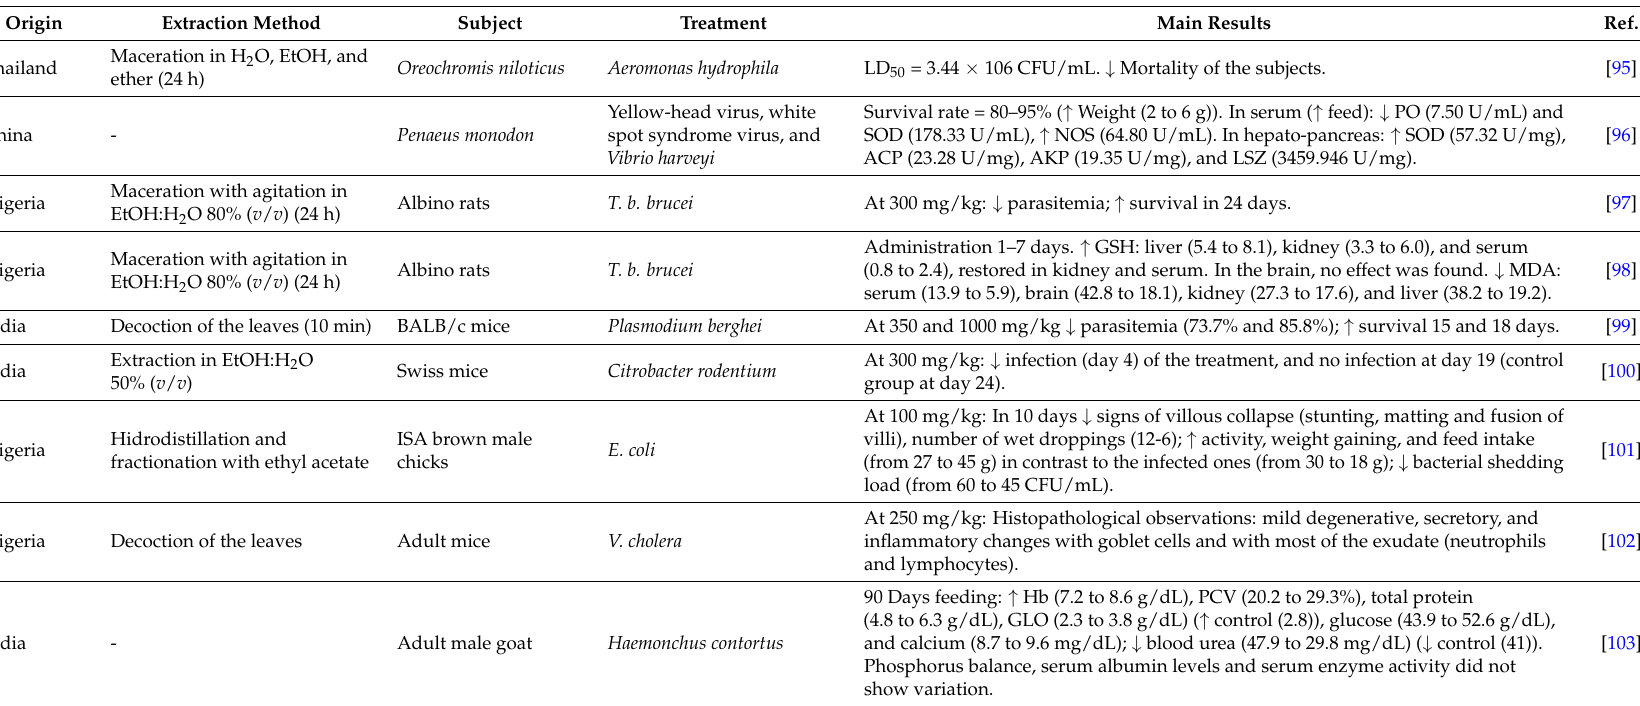
Table 6. In vivo anti-bacterial